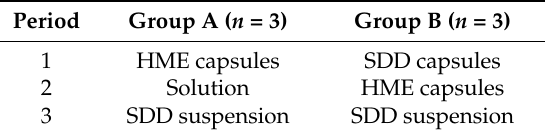
Table 2. Dosing Scheme for the dog study of